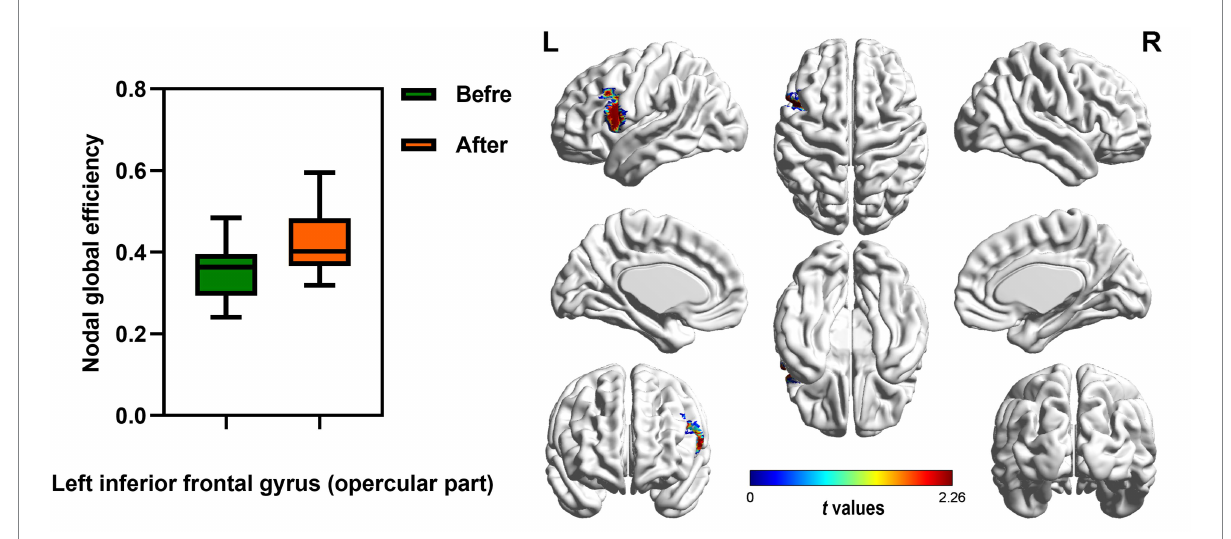
FIGURE 5 Brain region showed increased AUC of nodal global efficiency of male rowing athletes after tDCS. L: left cerebral hemisphere; R: right cerebral hemisphere. AUC, area under the curve; tDCS, transcranial direct current stimulation. Values of p were obtained by paired t tests. p < 0.05 indicated statistically significant